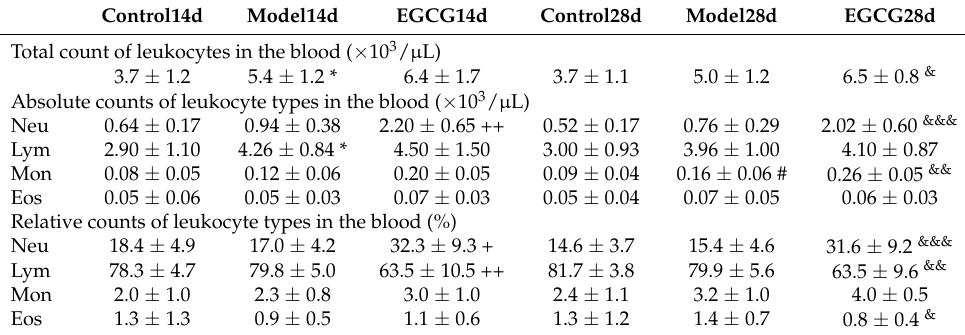
Table 1. Counts of leukocytes in the blood of saline-instilled animals (Control), silica-instilled non- treated animals (Model), and EGCG-treated silica-instilled animals (EGCG) after 14 days (14d) or 28 days (28d) of the treatment delivery.